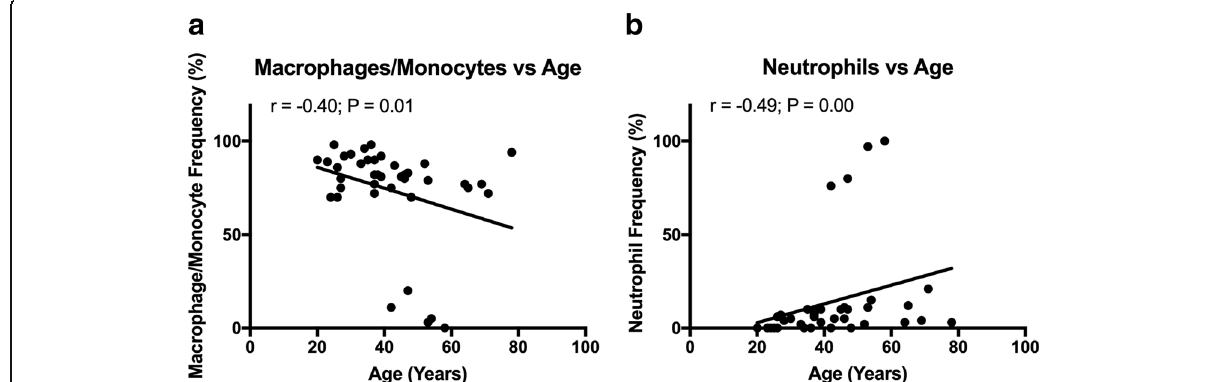
Fig. 4 Correlative relationships between a ) macrophage frequency and age, b ) neutrophil frequency and age. Significance determined at P < 0.05